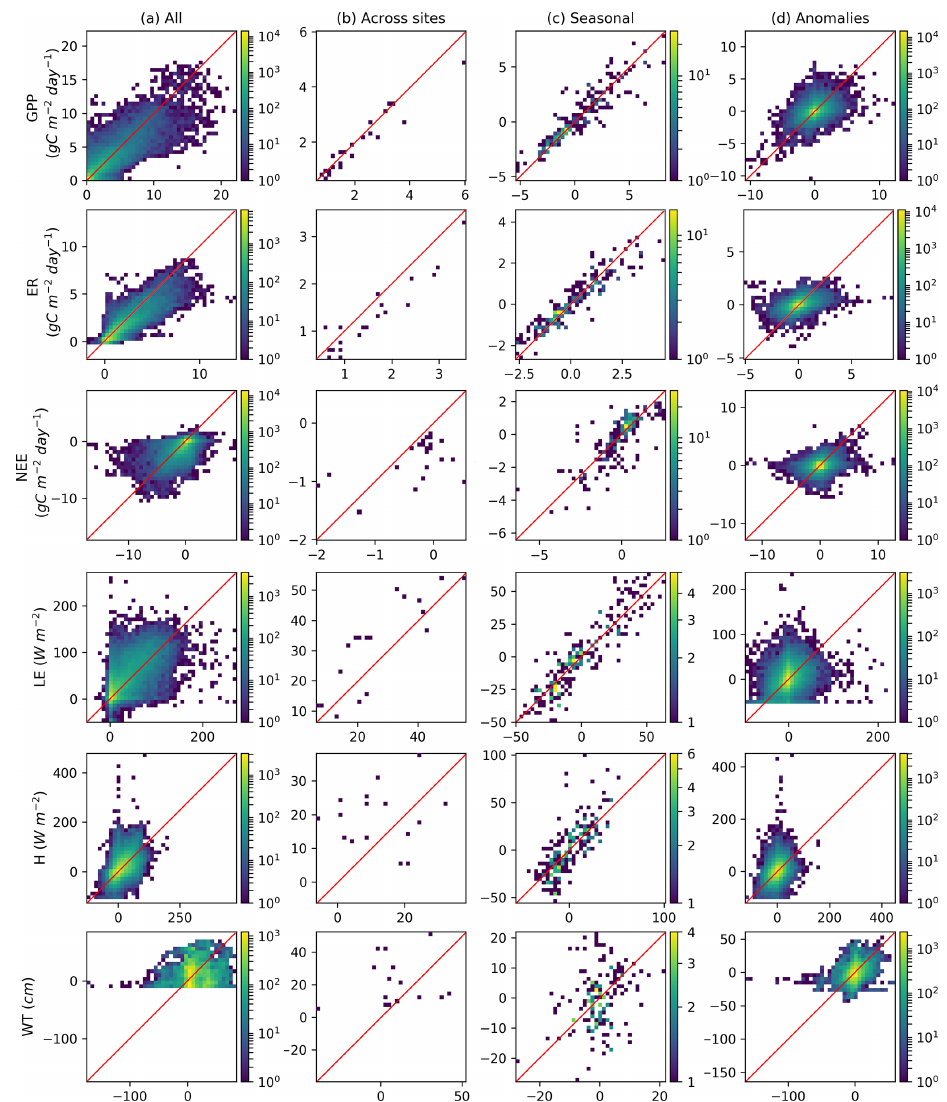
Figure 4. Observed ( x axis) vs. simulated ( y axis) fluxes (GPP, ER, NEE, LE, H, and WT) at the 22 sites where GPP derived from EC measurements were available. Fluxes were simulated using site-specific optimized V cmax . The colors of points indicate the amount of data in each bin; in panel (b) , each data point represents one peatland site. The red line shows the observations equal to the